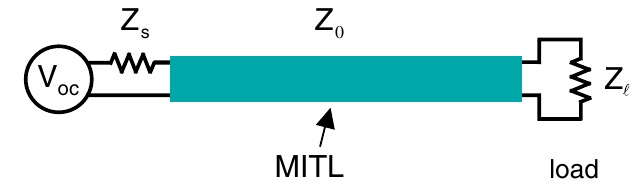
FIG. 11. (Color) Circuit model of an idealized MITL-load sys- is the open-circuit voltage that drives the system, Z tem. V oc is the geometric impedance of the the source impedance, Z 0 is the load MITL, and Z ‘